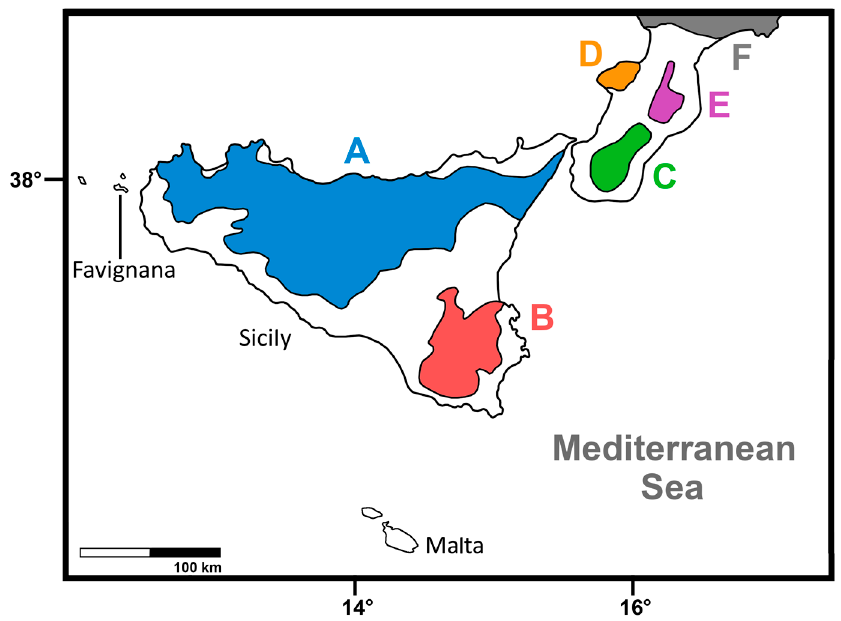
Figure 1. The Siculo-Maltese Palaeoarchipelago including present-day Sicily, Favignana and Malta. The palaeogeography of Calabria and Sicily during the Early Pleistocene is superimposed in colour (after [9]): ( A ) Northern-Central Sicily ( B ) Hyblean Plateau; ( C ) Aspromonte Massif ( D ) Cape Vaticano Massif ( E ) Serre Massif ( F ) Northern Calabria.